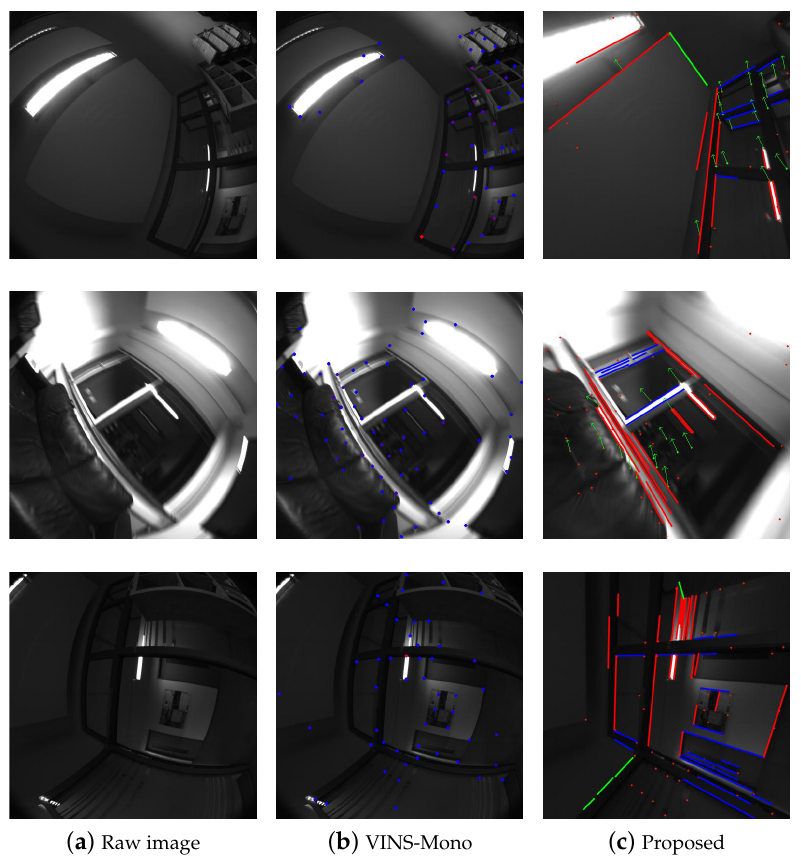
Figure 11. The feature extraction performance of VINS-Mono and our proposed system when the camera does fast motion. In VINS-Mono, the blue point features represent the lost